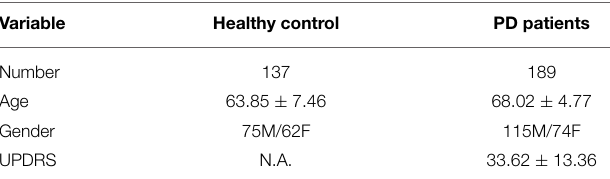
TABLE 2 | Demographics for the data in the PPMI dataset. Variable Healthy control PD